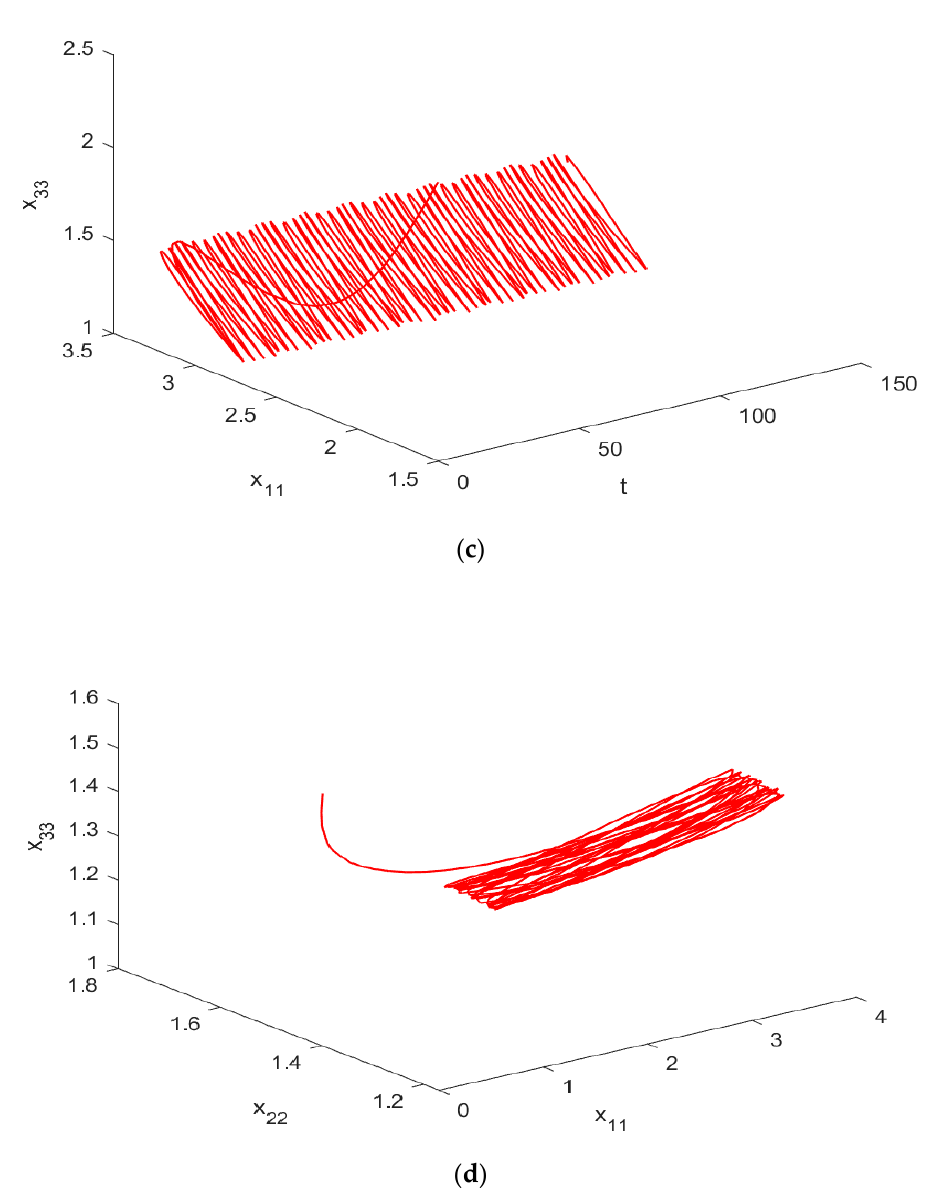
x x − , 3D graphs and initial values are ( a ) (3.5,1.0) ( b ) Figure 8. The state trajectory of x 11 − x 33 , 3D graphs and initial values are ( a ) ( 3.5,1.0 ) ( b ) ( 0.5,1.5 ) , Figure 8. The state trajectory of 11 33 ( c ) ( 0.0,1.5,2.5 ) , and ( d ) ( 0.5,1.5,1.5 ) , (0.5,1.5) ， ( c ) (0.0,1.5, 2.5), and ( d ) (0.5,1.5,1.5), respectively.